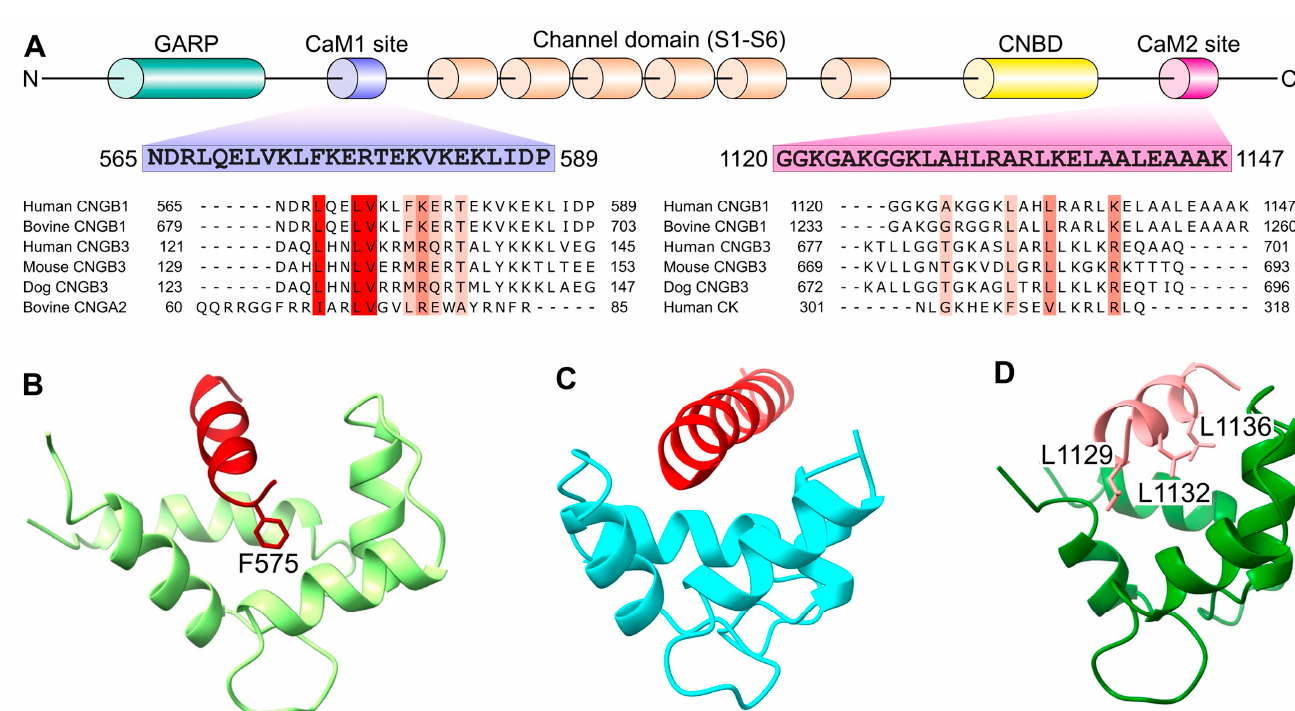
Figure 3. CaM binding sites in rod CNGB1 vs. cone CNGB3. ( A ) Domain architecture and amino acid sequence of CaM binding sites (CaM1 and CaM2) in CNGB1. Sequence alignment of CaM1 and CaM2 with corresponding residues in CNGA2, creatine kinase (CK), cone CNGB3 and vertebrate homologs of CNGB1. Conserved residues are highlighted in color. ( B ) NMR structure of the Ca 2+ -bound CaM N-lobe (light green) bound to CaM1 peptide (red) [53]. ( C ) Cryo-EM structure of CaM C-lobe (cyan) bound to the D-helix of CNGB1 (red) [13]. ( D ) NMR structure of the Ca 2+ -bound CaM C-lobe (dark green) bound to CaM2 peptide (pink)